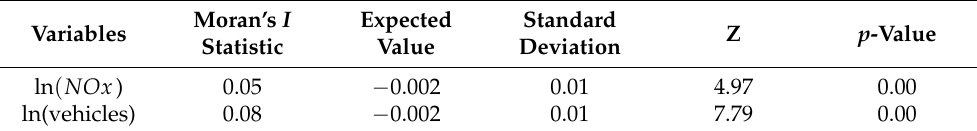
Table 6. Results of Moran’s I